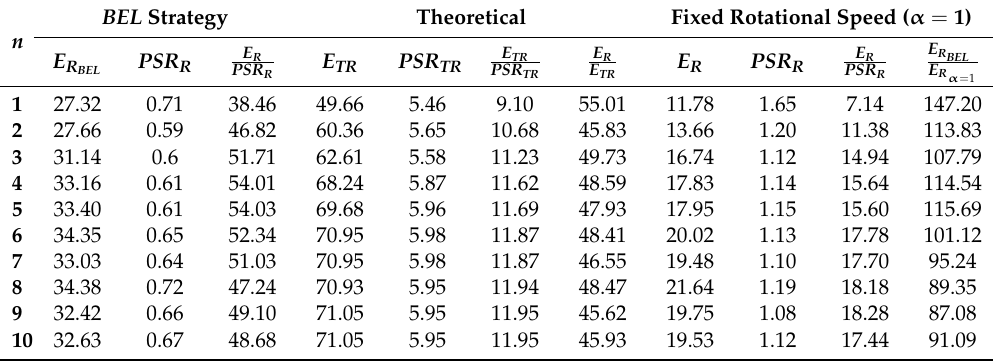
, MWh; E R , E TR PSR R